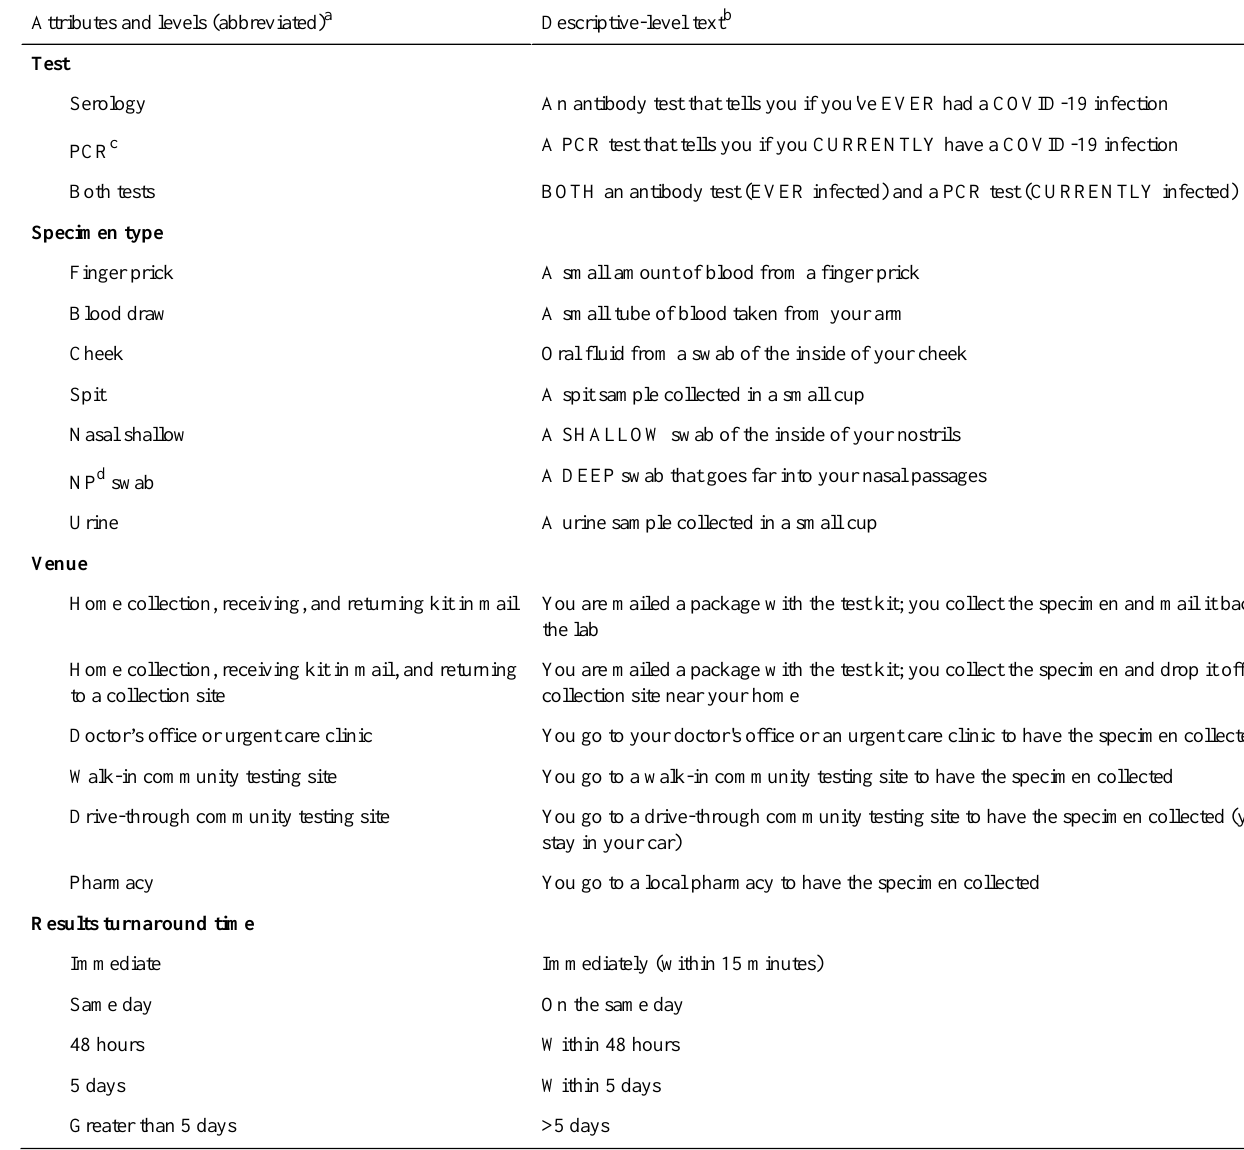
Table 1. SARS-CoV-2 testing discrete choice experiment attributes and levels.